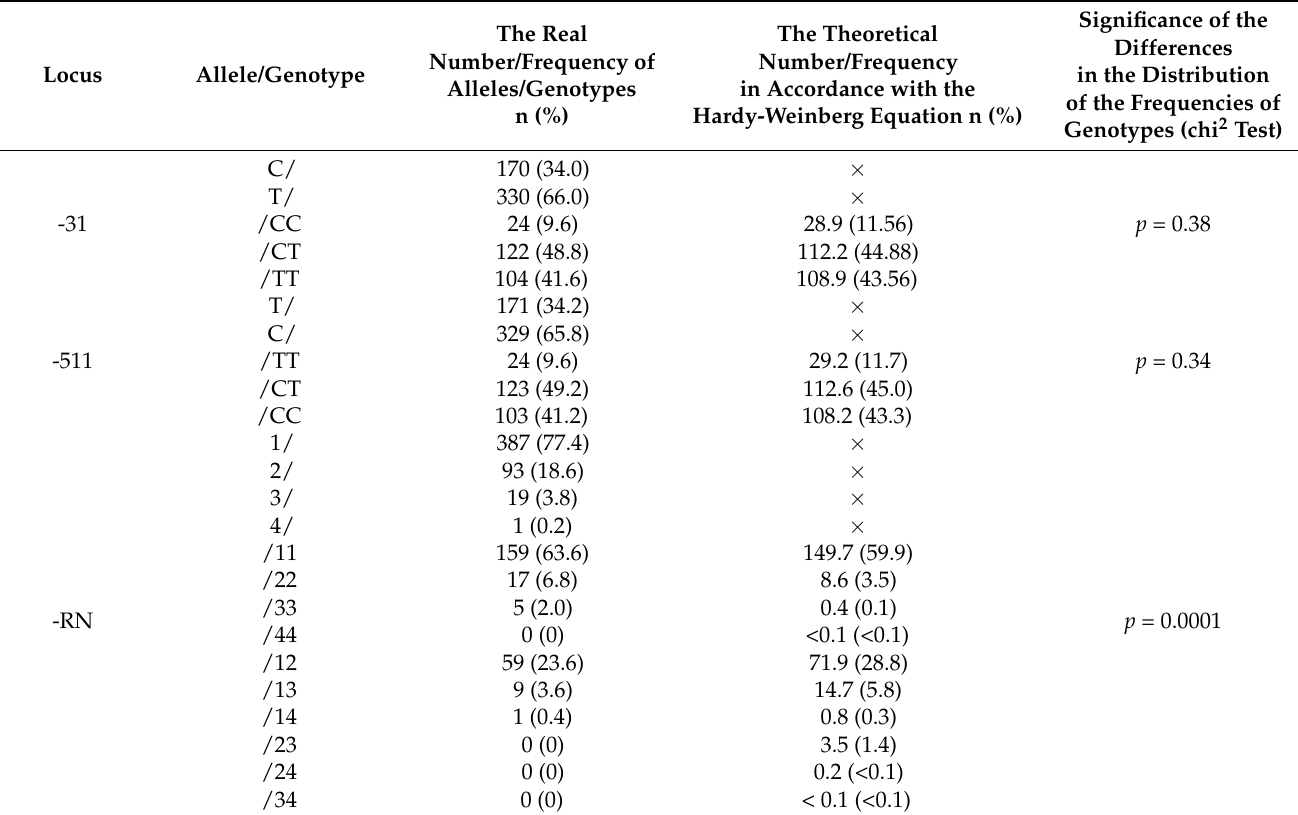
Table 5. The observed distribution of the alleles and genotypes at loci -31 and -511 of the IL-1B and IL-1RN genes and the theoretical distribution of